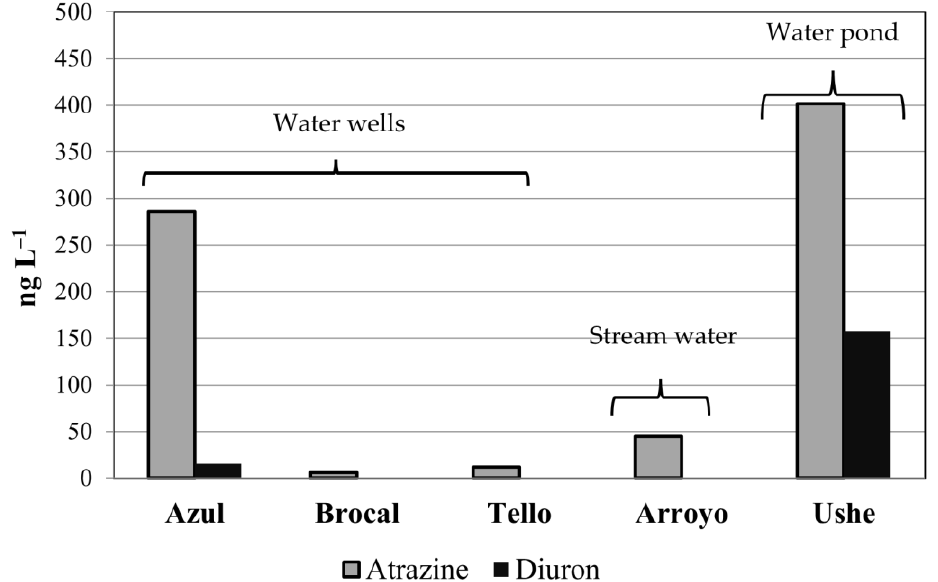
Figure 2. Classification of sample sites and herbicide concentrations.